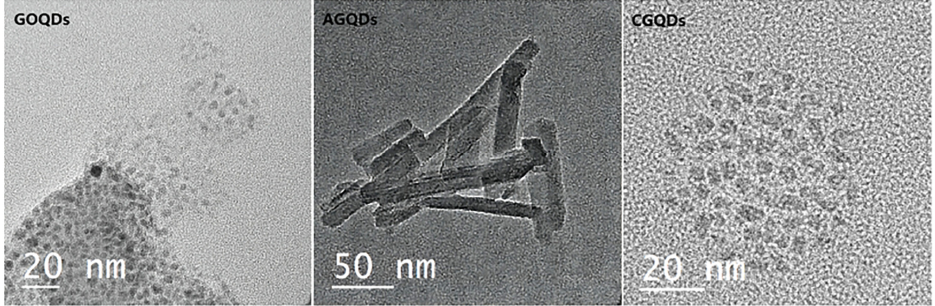
Figure 1. The TEM of three kinds of Graphene Quantum Dots. Table 1. The proportion of elements in the three kinds of Graphene Quantum Dots. Element Proportion (%)